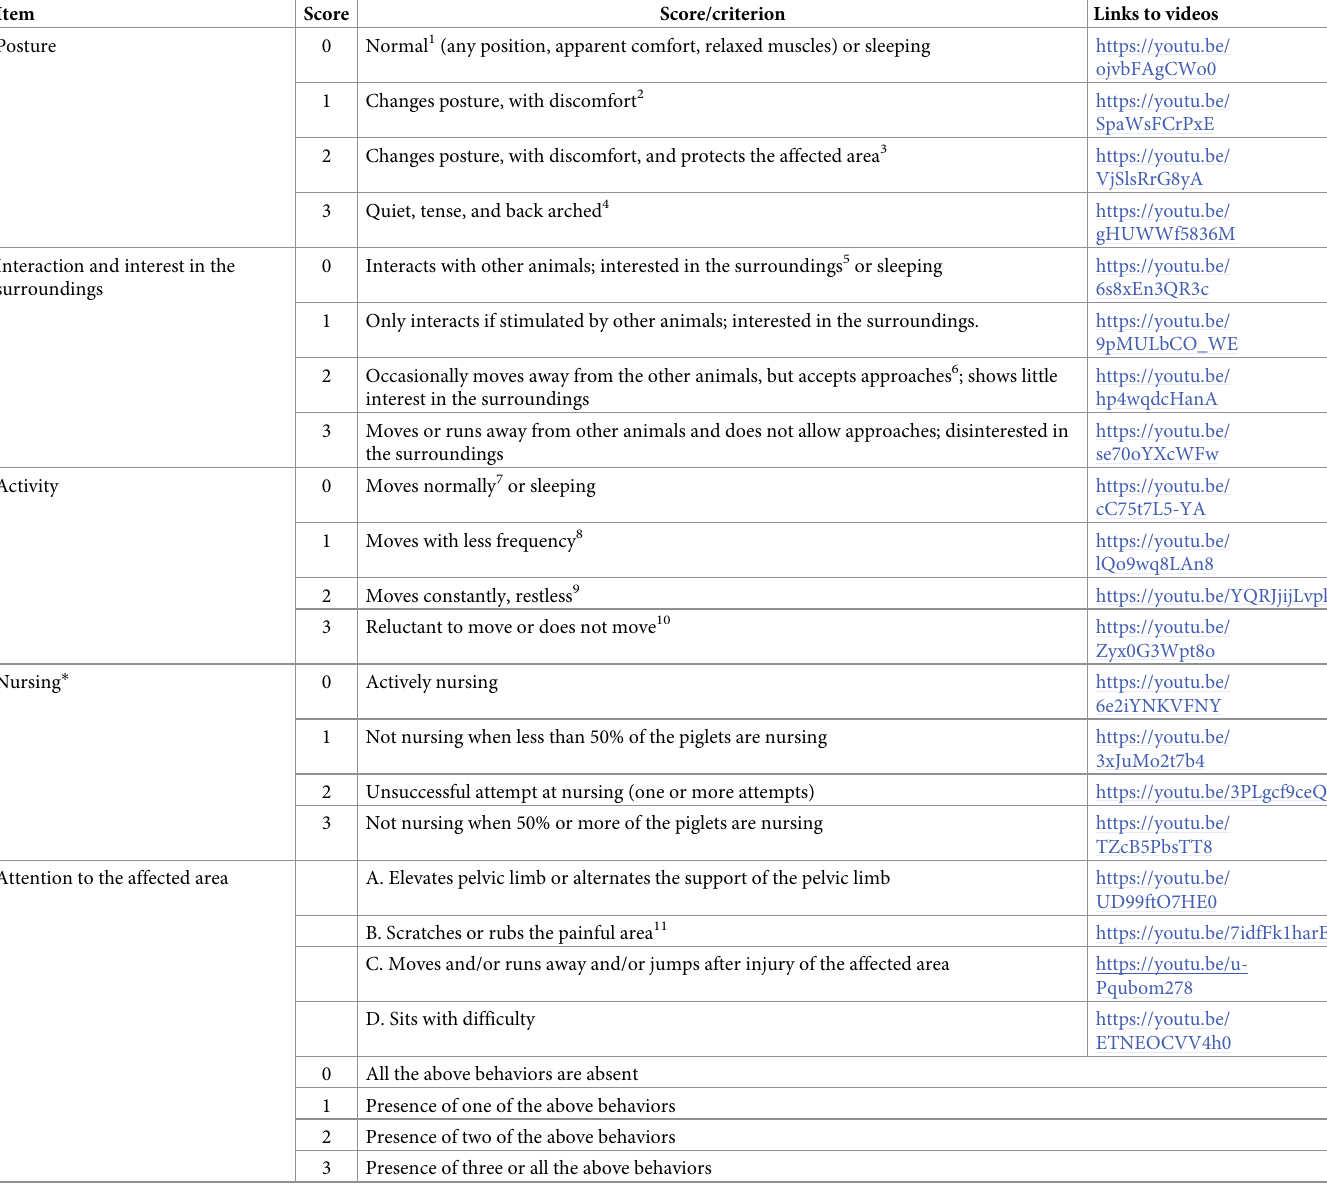
sessions (2h/training session) where observers studied components of the scale, observed, and discussed examples of each behavioral score/criteria and practiced scoring for 90 min. Subse- quently, inter-observer reliability was assessed, and intra-class correlation coefficient (ICC) was calculated by having each observer score twelve animals individually. Videos were observed in random order and observers were masked to day and time of day. Scale adaptations. The pain scale validated in this study evaluated six behavioral items, with each item sub-categorized into four descriptive levels. A numerical score was designated from “0” to “3”, with a “0” representing normal behavior (free of pain) and “3” corresponding to pronounced behavioral deviation (Table 1). For the purposes of this study, two adaptations Table 1. The Unesp-Botucatu composite pain scale for assessing postoperative pain in piglets (UPAPS).